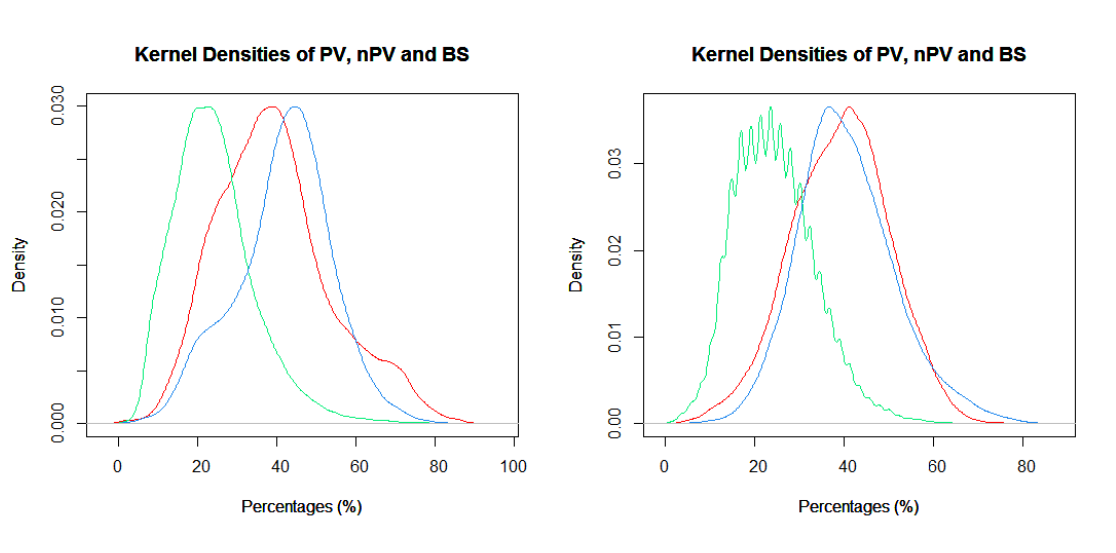
Figure 4. Kernel Density plots of all Landsat FCover bands representing the individual fractions of bare soil in red, green vegetation in green, not green vegetation in blue in one pixel. ( a ) December 1987, ( b ) December 1988, ( c ) December 1989 and ( d ) December 1990. The histograms indicated a roughly normal distribution for each of the classes. It can be seen that the green vegetation has the smallest fractions. In 1988, 1989 and 1990 the green vegetation was represented as the smallest fraction but with the highest frequency, except in 1987 where the bare